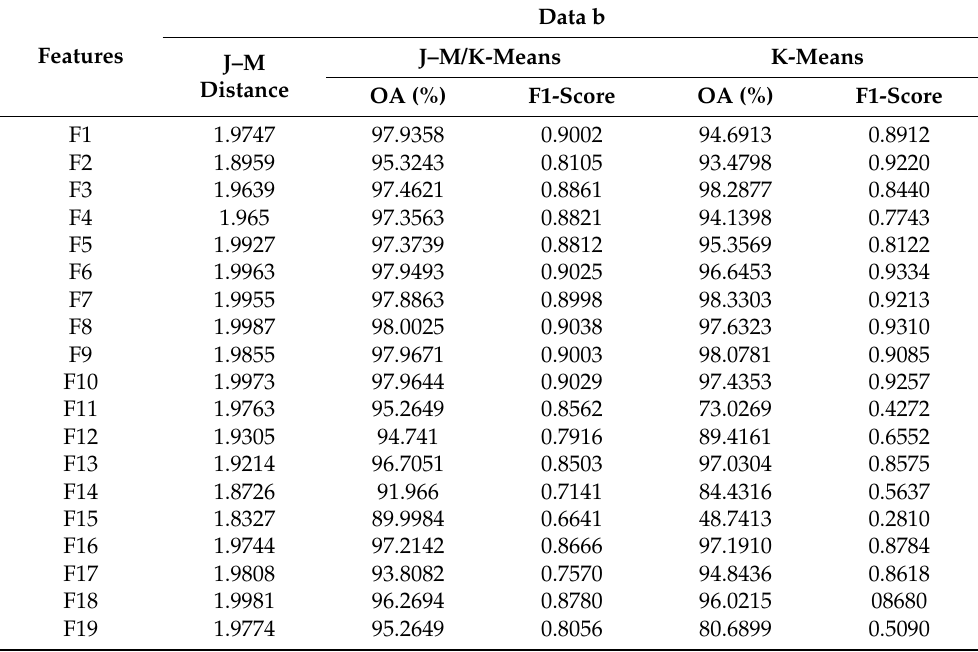
Table 3. Oil spill detection feature J–M distance and evaluation results of data